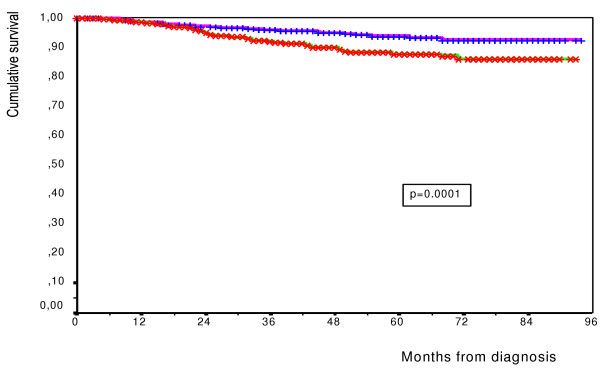
5-yearOS. 5-year OS between MSP participants and non-participants was equal to 94% and 84% respectively (Log Rank = 14.99). [ = MSP participants  = MSP non-participants]